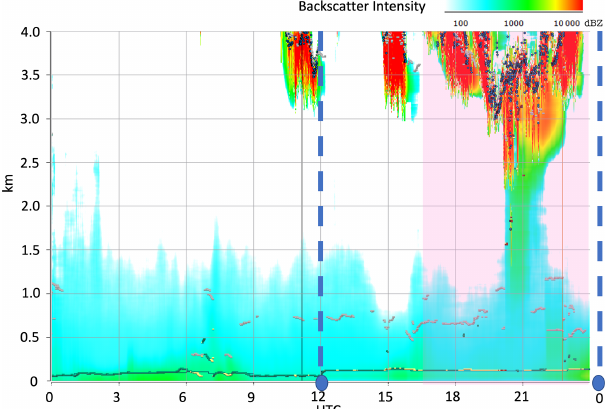
Figure 5. Virga event from 31 March 2015 (shaded region), when a columnar aerosol profile can be seen at approximately 20:00– 22:00UTC, reaching the surface aerosol layer. The dashed blue lines and circles indicate the availability of radiosonde